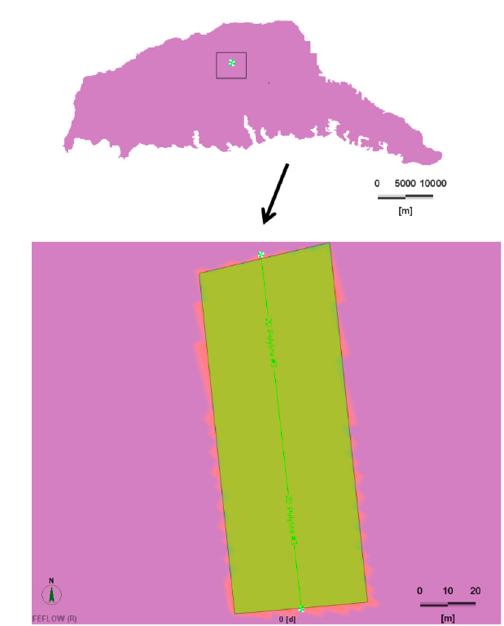
Figure 11. North–south cross-section of the area. Figure 11 North–south cross-section of the area.